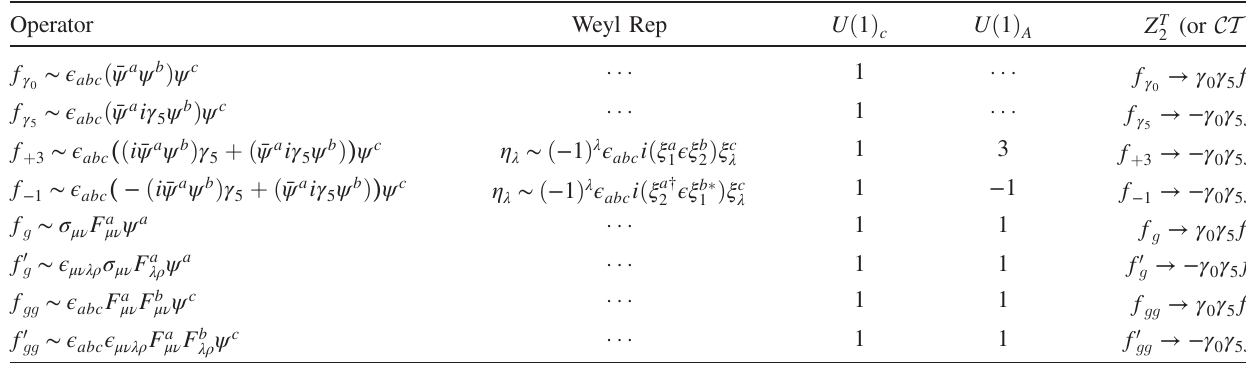
TABLE III. A summary of Lorentz